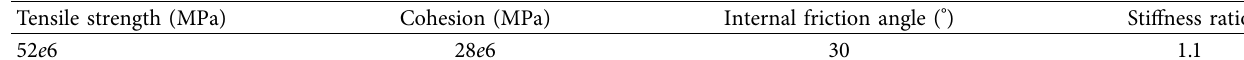
Table 4: Micro bond parameters of coal particles.